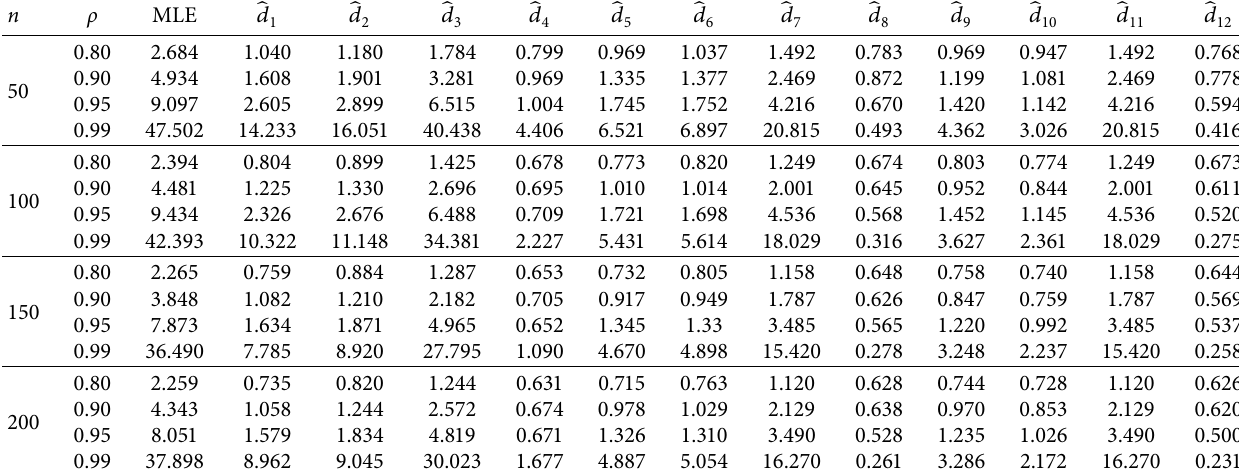
Table 2: Estimated MSEs of the COMPRM estimators, when p � 3 and ϑ � 1.